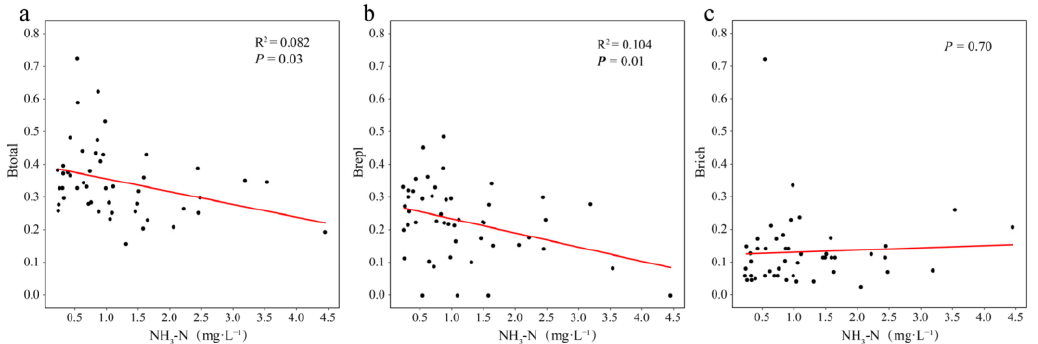
Table 2. The average and variance values of beta diversity in Group I and Group II. Figure 5. Linear regression relationships between beta diversity (( a ): Btotal; ( b ): Brepl; ( c ): Brich) and the concentration of NH 3 -N in the rivers of Shanghai City.